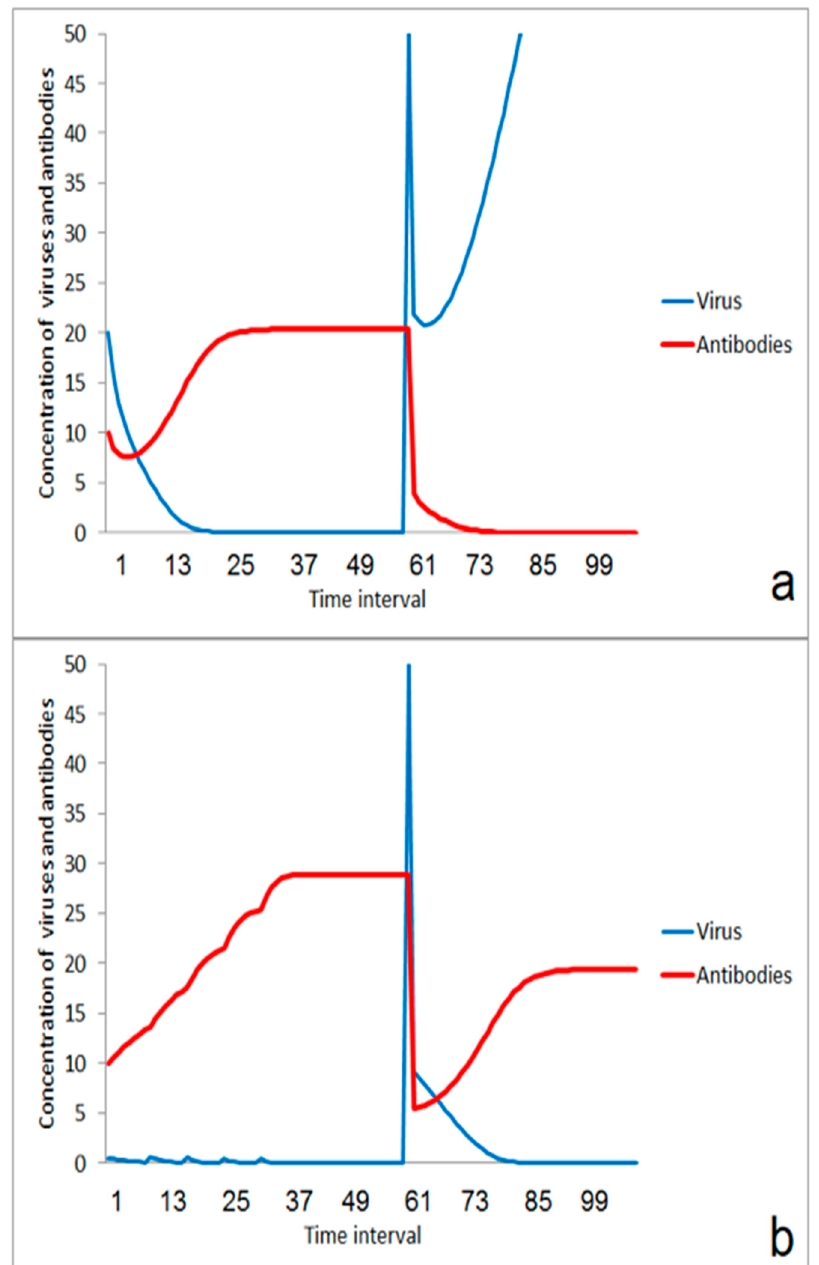
Figure 8. Effect of a series of low-level multi-impact events for improvement of immune response: ( a ) outbreak of disease after a strong stimulation at the beginning, ( b ) suppression of the infection after a series of small impact events.